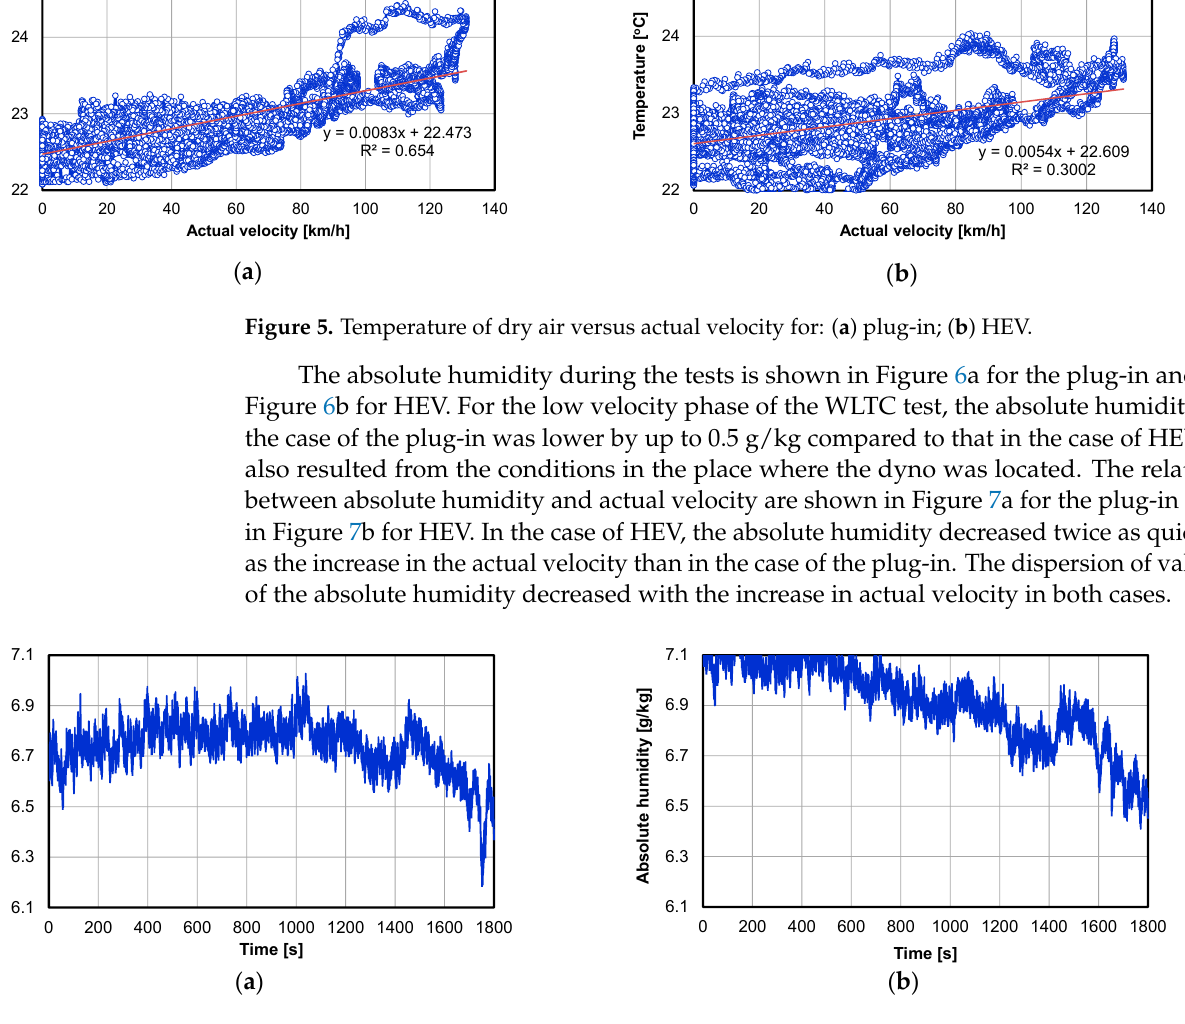
( b ) Figure 7. The absolute humidity versus actual velocity for: ( a ) plug-in; ( b ) HEV. The relative humidity during the tests is shown in Figure 8a for the plug-in and in Figure 8b for HEV. The relative humidity in the case of the plug-in was lower by 1–3% compared to that in the case of HEV. Such differences were higher for the lower velocities during the WLTC tests. It also resulted from conditions in the place where the dyno was located. ( a ) ( b ) Figure 8. The relative humidity versus time for: ( a ) plug-in; ( b ) HEV. 4.1.2. Measurement of the Concentration of Polluting Compounds